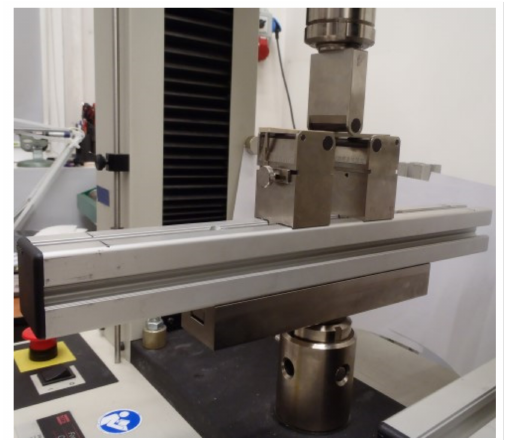
Figure 3. Stand for the three-point bending